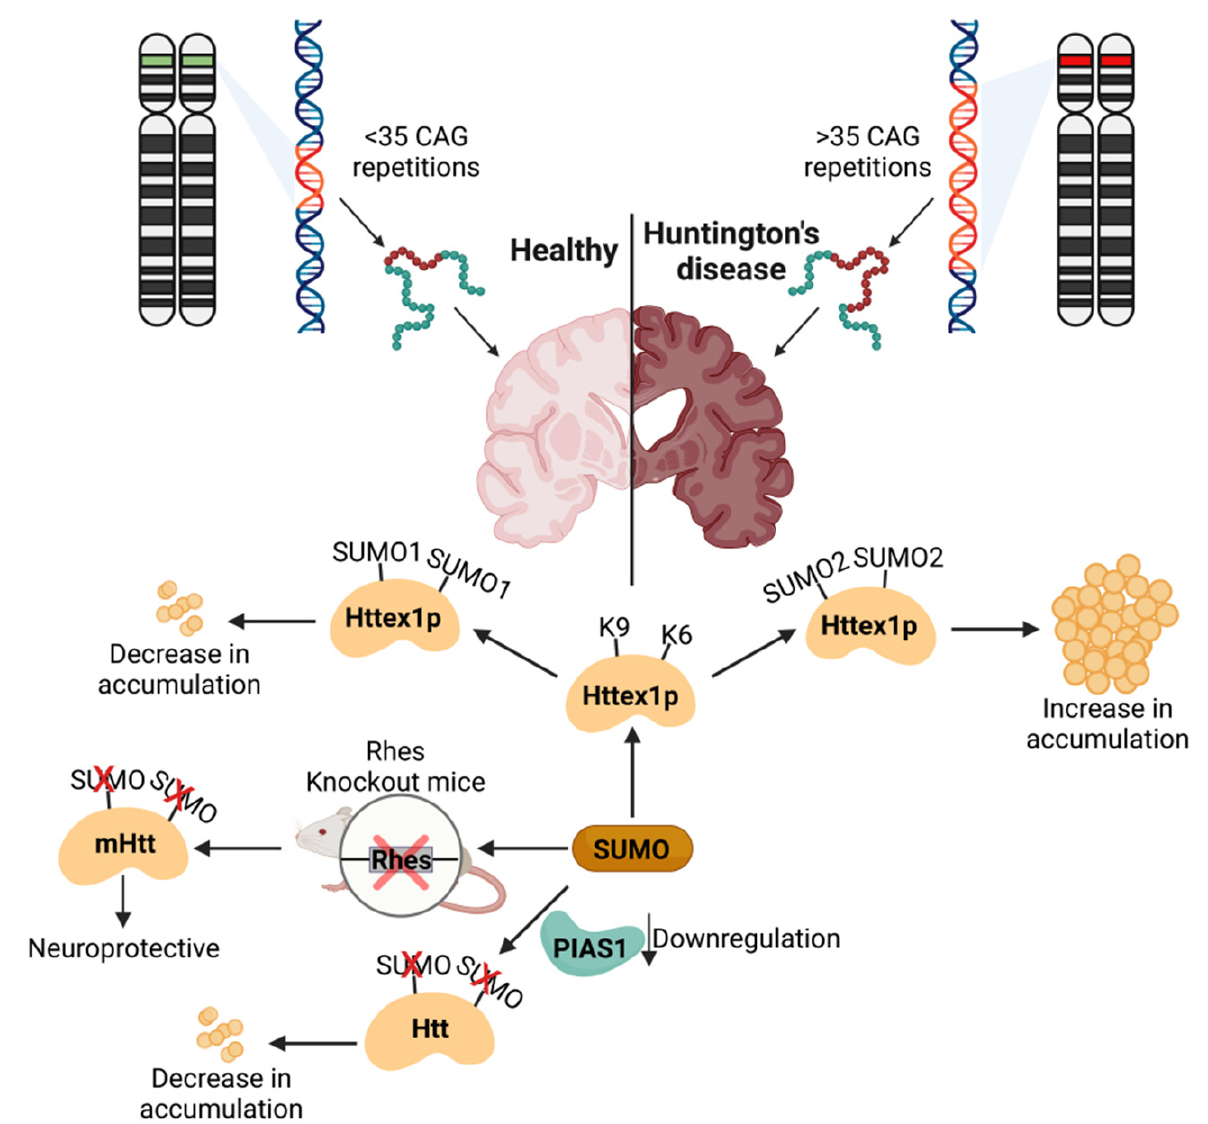
Figure 4. SUMOylation in Huntington’s disease: SUMOylation of Httex1p has an ambivalent effect and can either decrease or increase the solubility, depending on if it is SUMO1- or SUMO2-attached. The downregulation of PIAS1 in the striatum leads to the reduced SUMOylation of HTT and de- creased accumulation. Rhes knockout in mice has been shown to have beneficial and neuroprotec- tive effects in Huntington’s disease. Figure was created with BioRender.com.